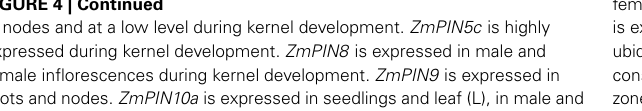
expressed during kernel development. ZmPIN8 is expressed in male and female inflorescences during kernel development. ZmPIN9 is expressed